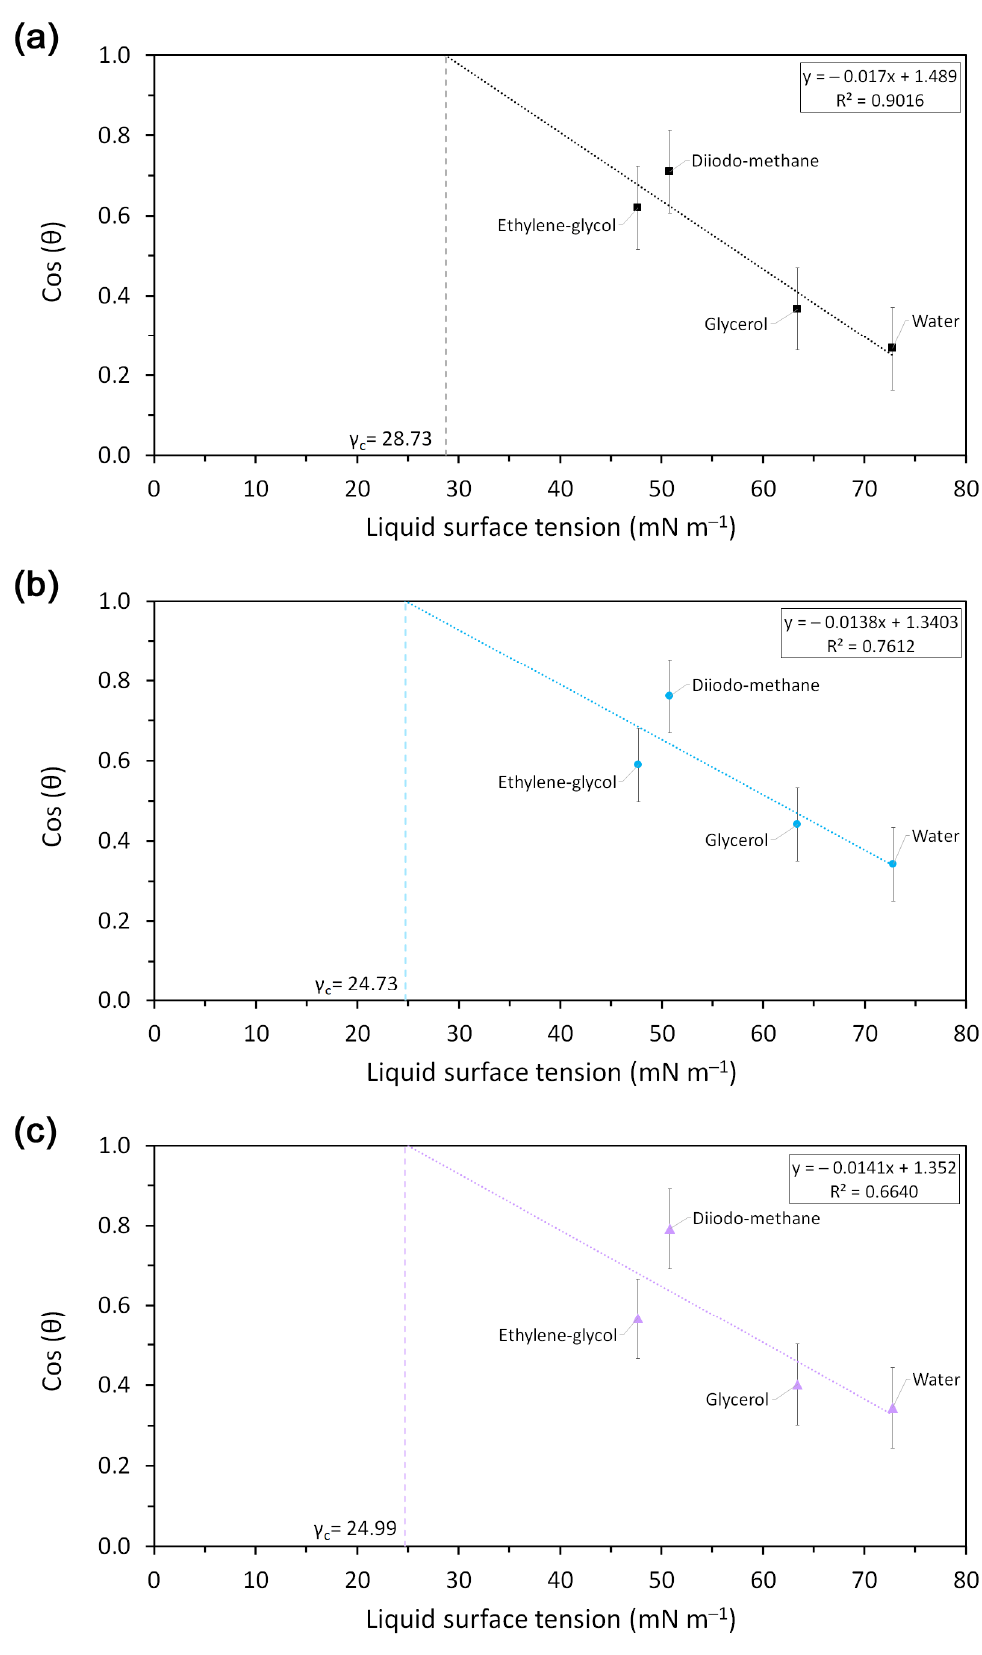
Figure A1. Zisman plot from goniometric measurements for ( a ) P0, ( b ) P5 and ( c ) P10 (experimental values and linear regression).